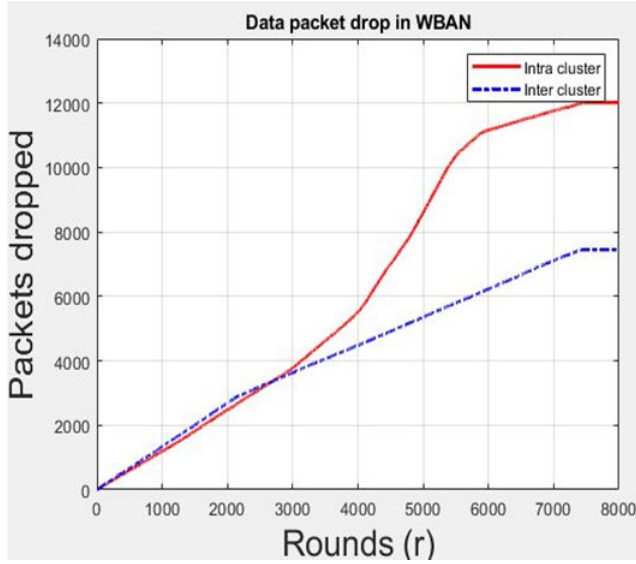
Figure 9. Data packet drop in WBAN